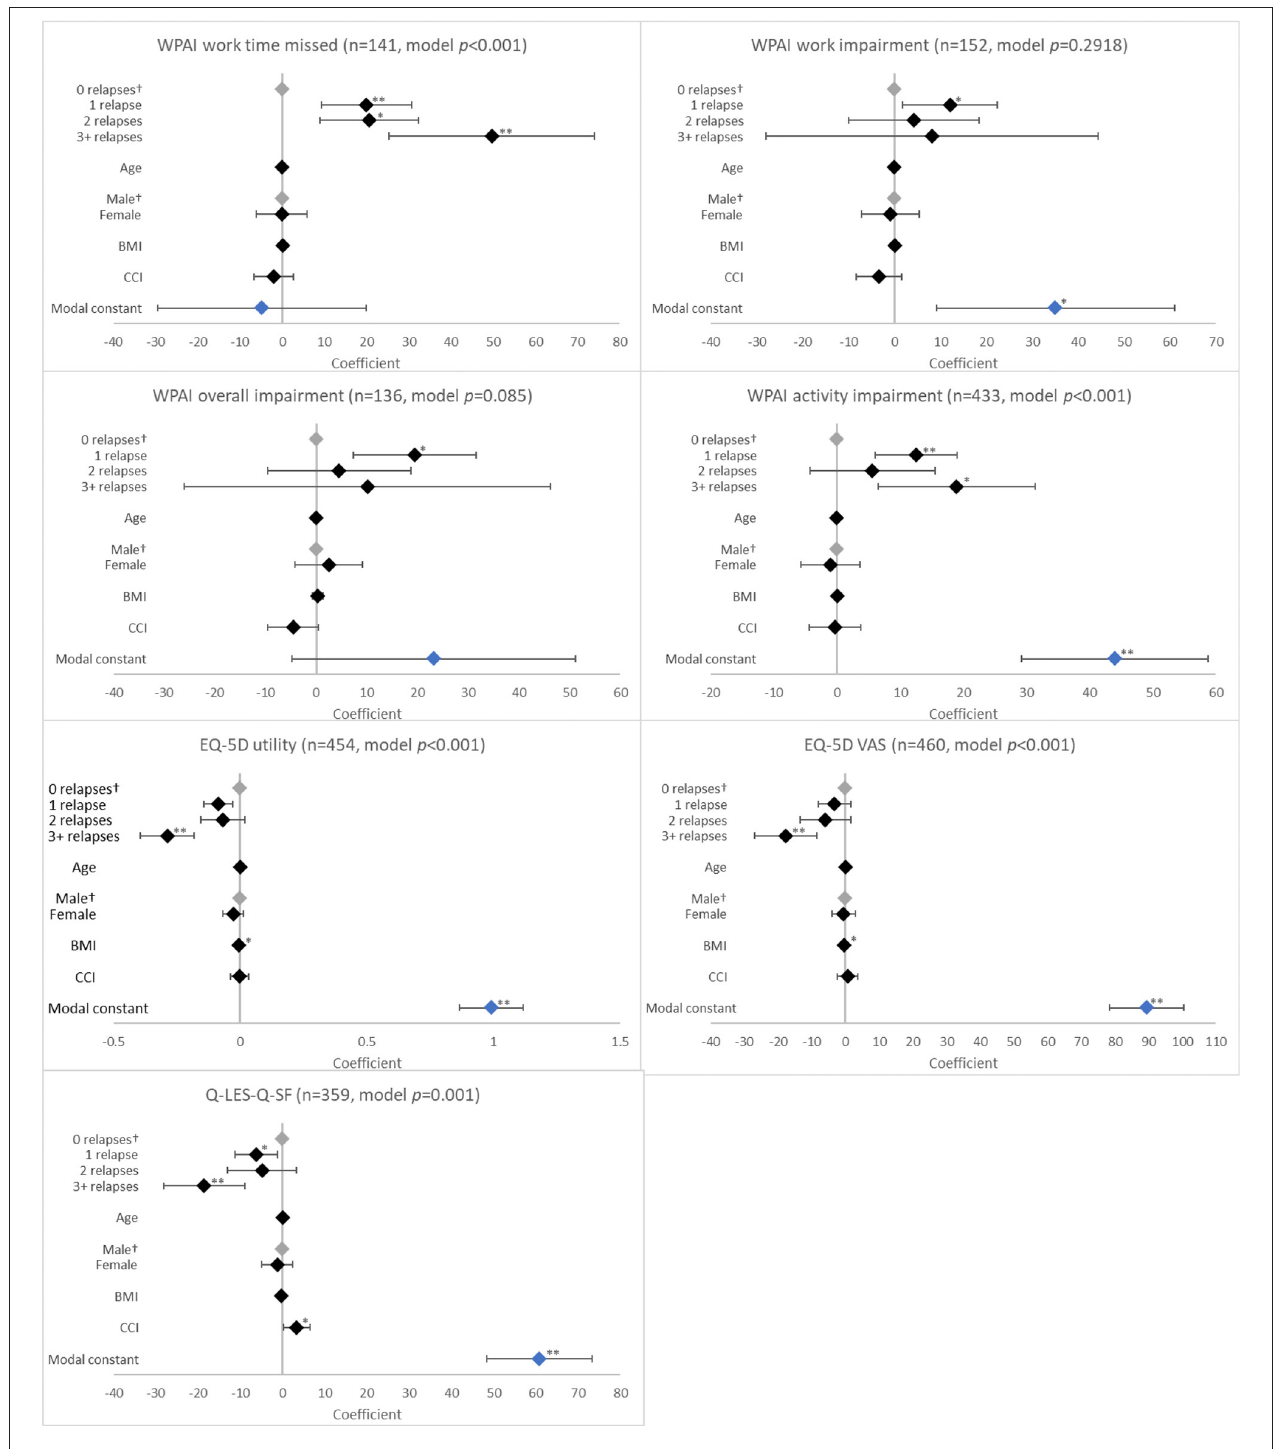
FIGURE 3 | Association between validated patient-reported outcomes and the number of relapses in the last 12 months. † Base level, * p < 0.05 and ** p < 0.001. Likelihood ratio p -values are referenced in Table 2 . BMI, body mass index; CCI, Charlson comorbidity index; EQ-5D, EuroQol 5-Dimension; Q-LES-Q-SF, Quality of Life Enjoyment and Satisfaction Questionnaire; VAS, Visual Analogue Scale; WPAI, Work Productivity and Activity Impairment Scale. Grey diamonds indicate base level. Blue diamond indicates the model constant.